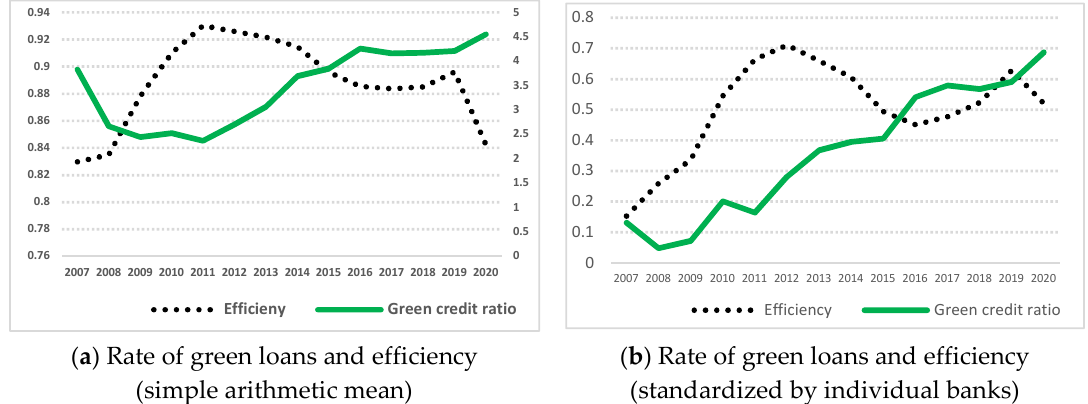
Figure 7. Green credit ratio and operating efficiency (trend comparison under different averaging methods).